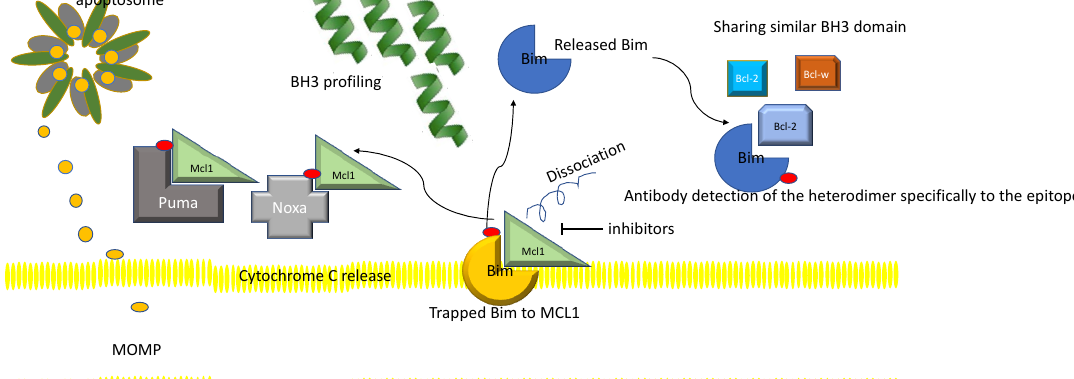
Fig.2 Interrelationship among BH3 domain containing proteins, induction of MOMP, predictive biomarkers